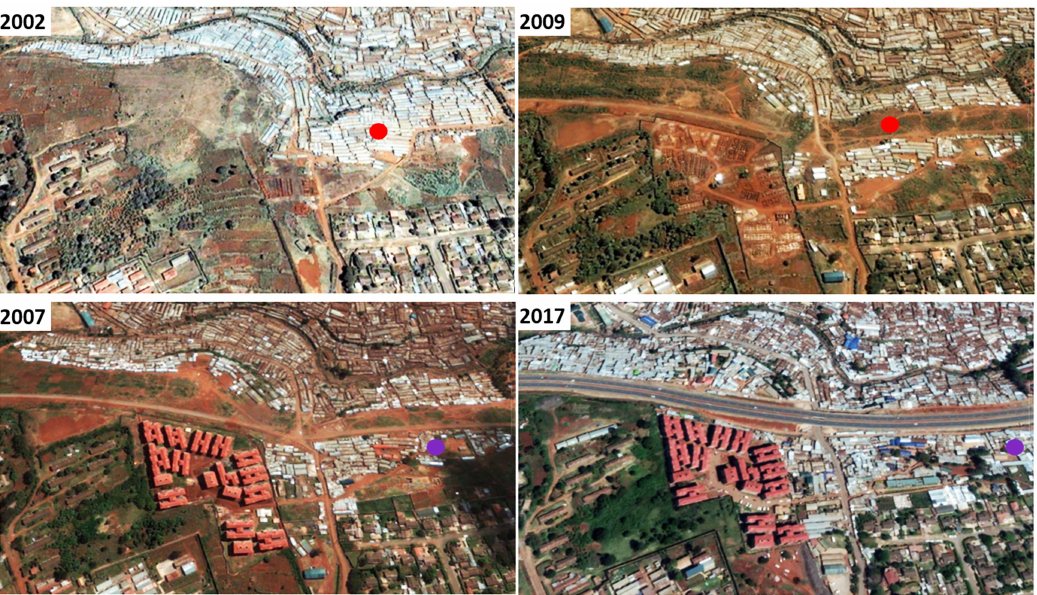
Figure 13. Disappearance and growth of deprived areas driven by infrastructure and formal housing developments (red dot: example of an evicted area causing the incremental growth of deprived areas in the surrounding—purple dot) (Image source: Google